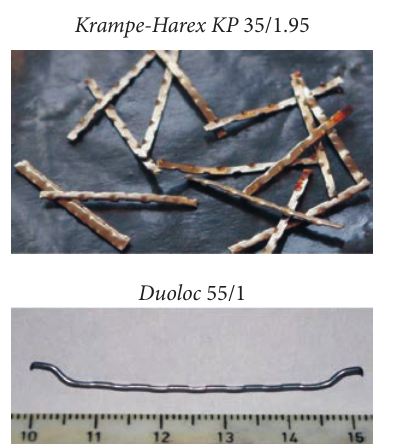
Fig. 2. The tested fibres